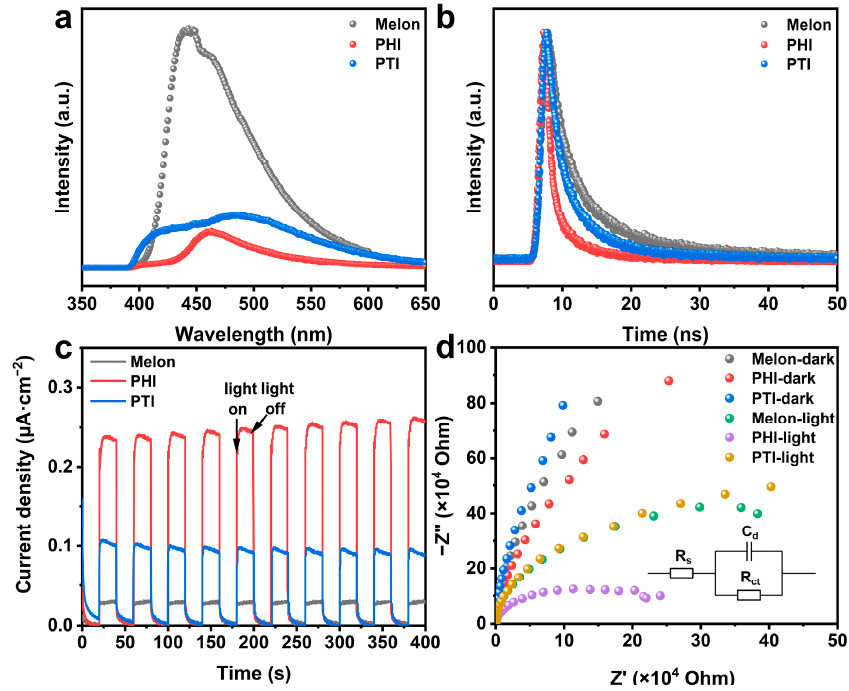
Figure 6. Photoelectric properties of the g-C 3 N 4 samples. ( a ): Steady-state PL spectra. ( b ): Time-resolved PL spectra. ( c ): Transient photocurrent response. ( d ): EIS pro fi le in dark and under light irradiation.